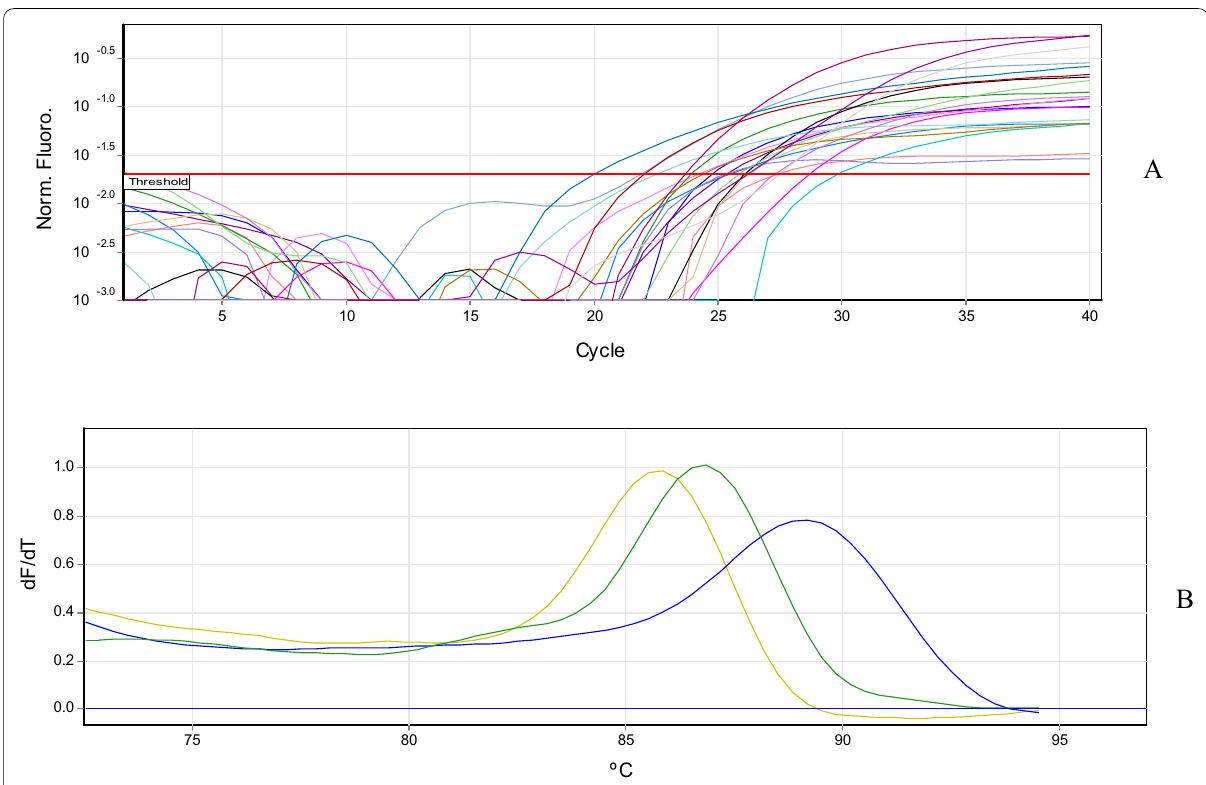
(Fig. 2). Amplification plot and melting curve analysis